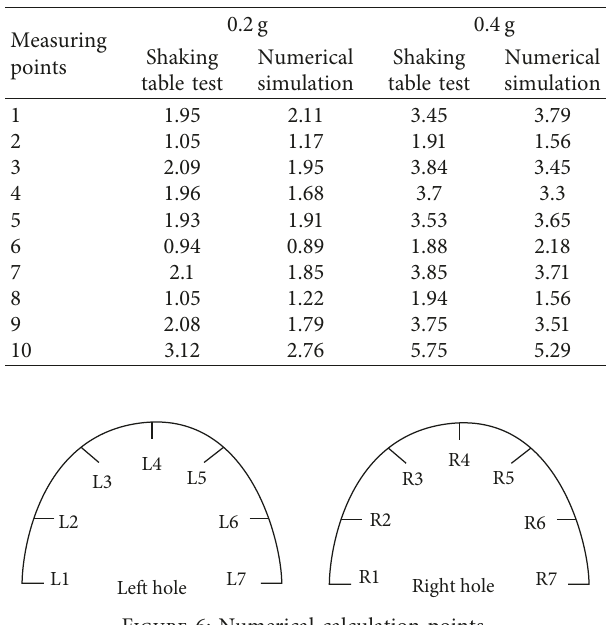
Table 5: Comparison of acceleration response peak value in the